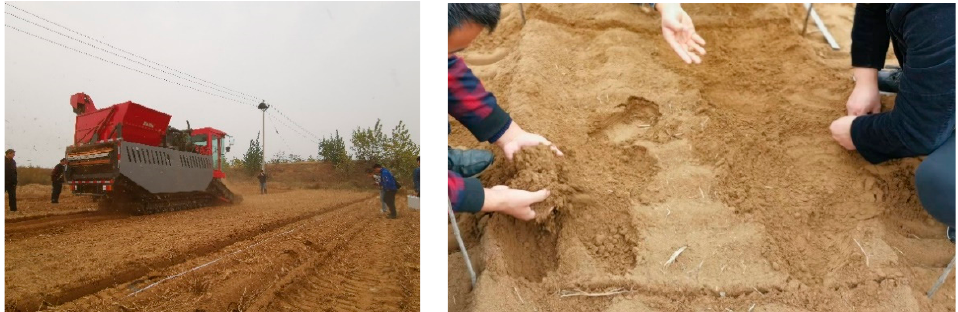
Figure 13. Trials for field harvesting.